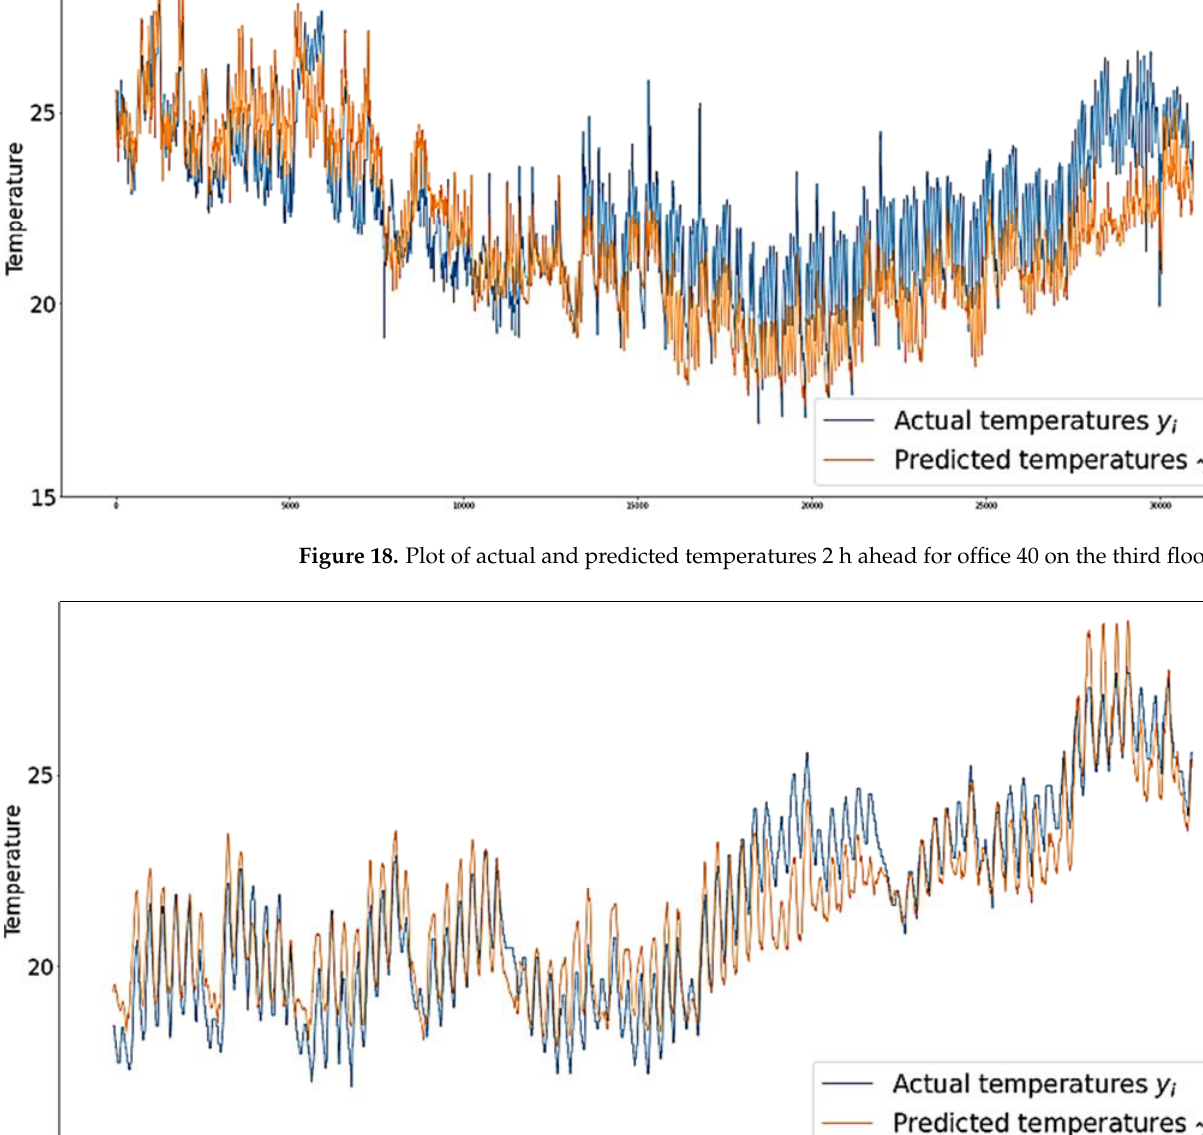
Figure 19. Plot of actual and predicted temperatures 5 h ahead for office 40 on the first floor.